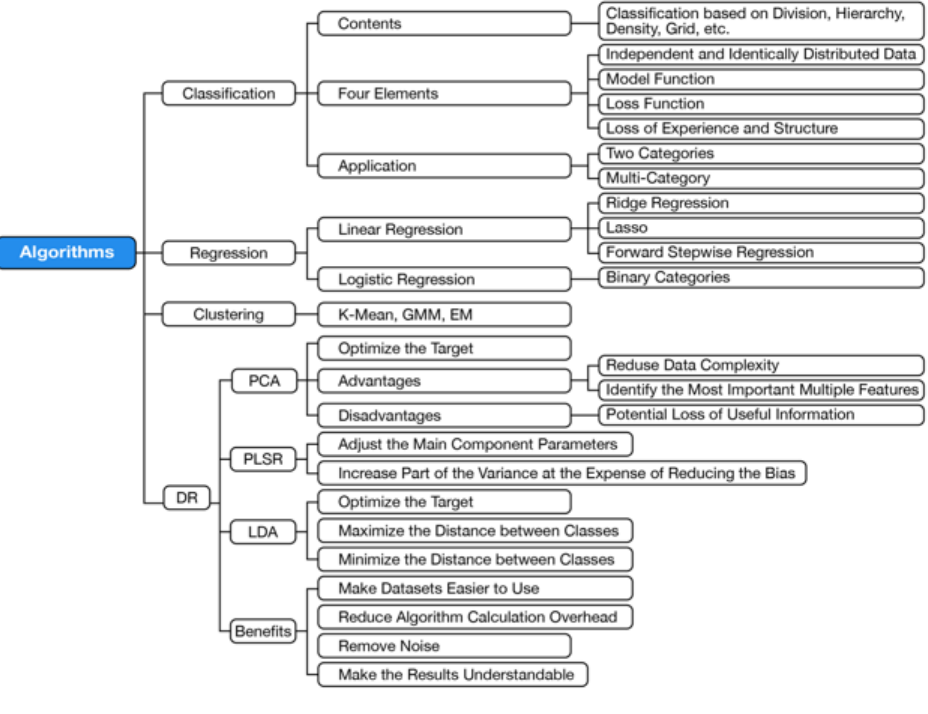
Figure 7. Machine learning tasks and main